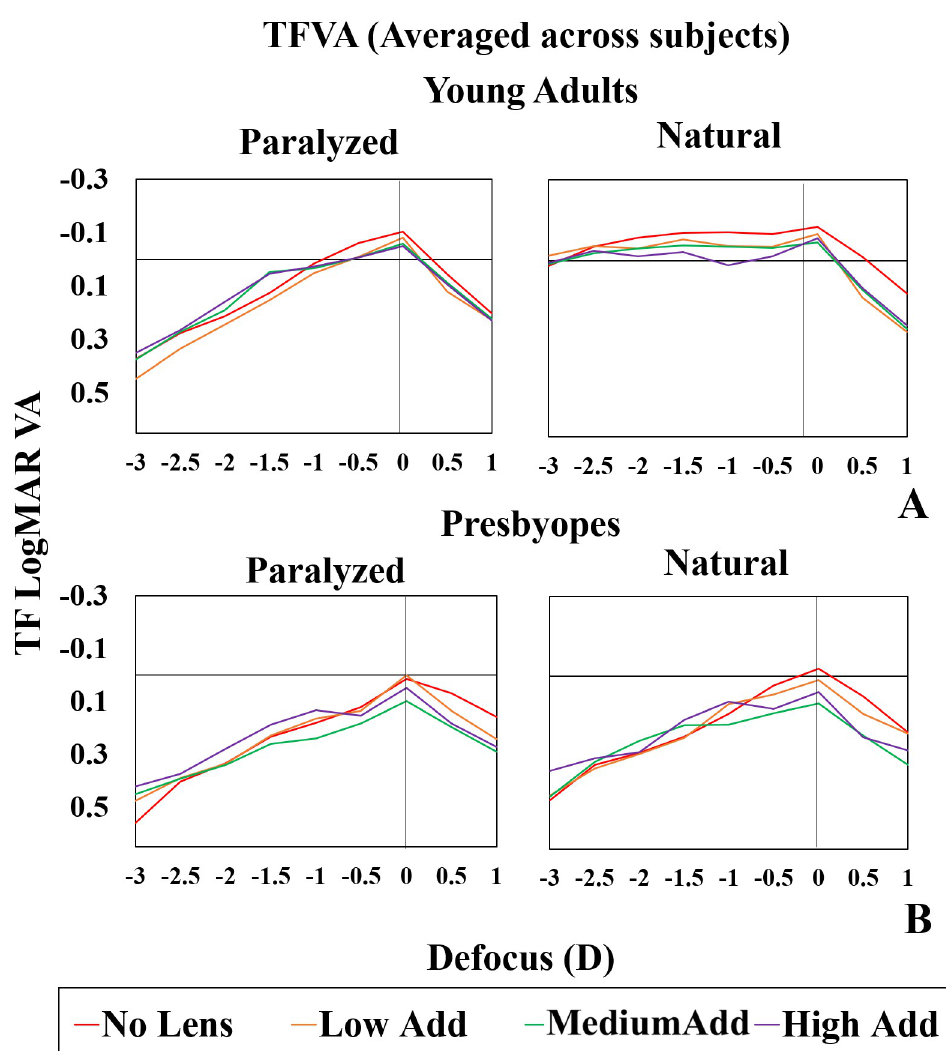
Fig 5. Average TF logMAR VA, across all subjects in the two study groups for paralyzed and natural accommodation. (A) Average TFVA curves for young adults; (B) Average TFVA curves for presbyopes. Left plots: paralyzed accommodation; Right plots: natural accommodation. Each lens condition identified by color—Red: NoLens; Orange: LowAdd; Green: MediumAdd; Purple: HighAdd.